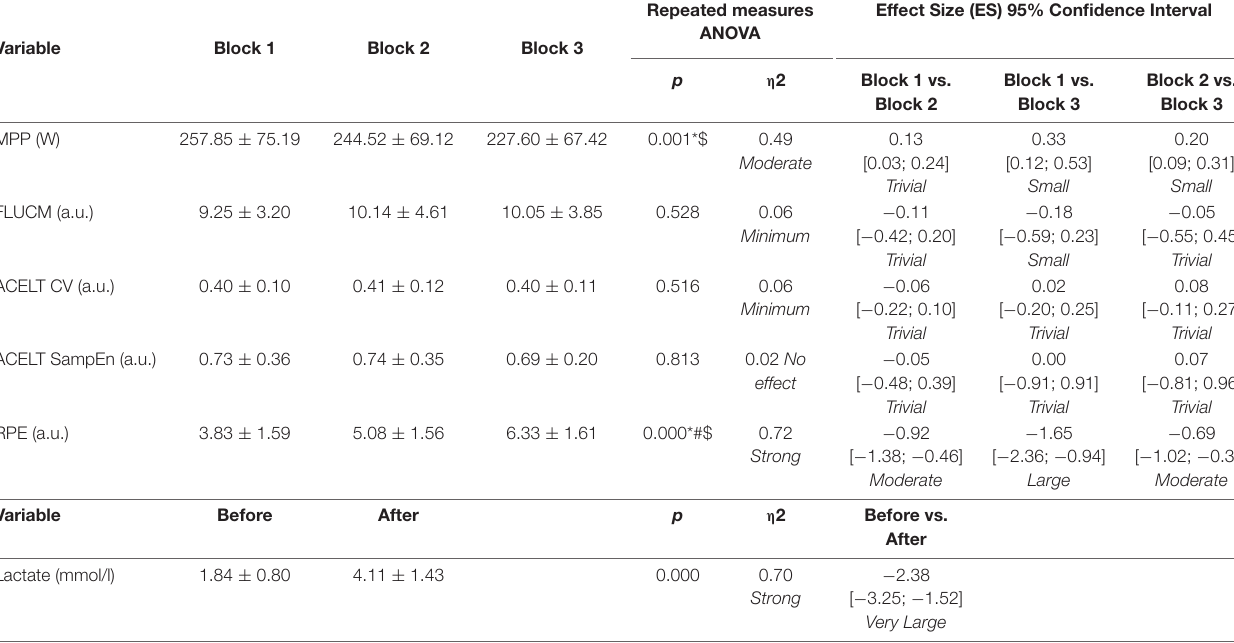
TABLE 5 | Between-blocks comparisons in the mechanical and perceptual variables – Parallel Bench